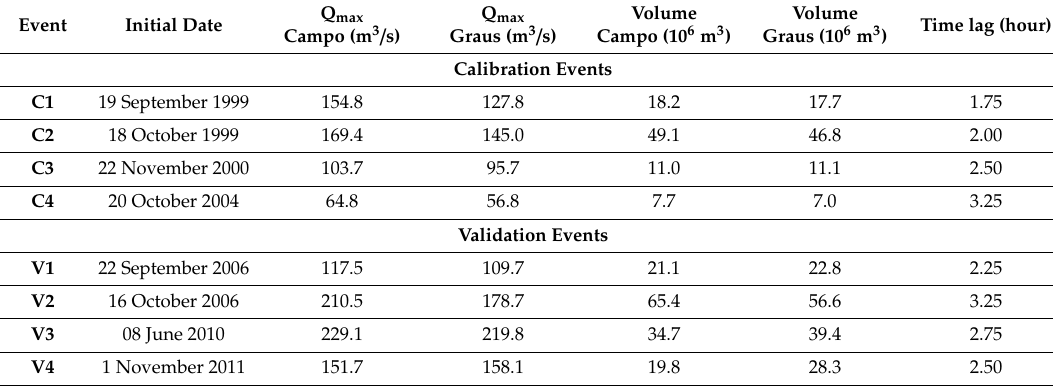
Table 1. Historical floods statistics.